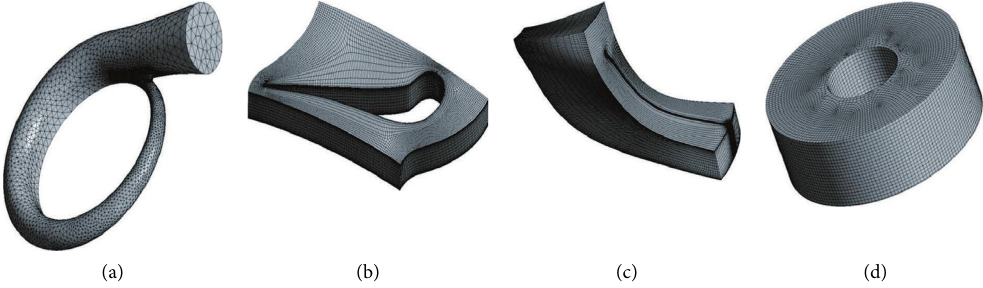
Figure 10: Mesh of the turbine component. (a) Volute, (b) Nozzle (c) Impeller (d)